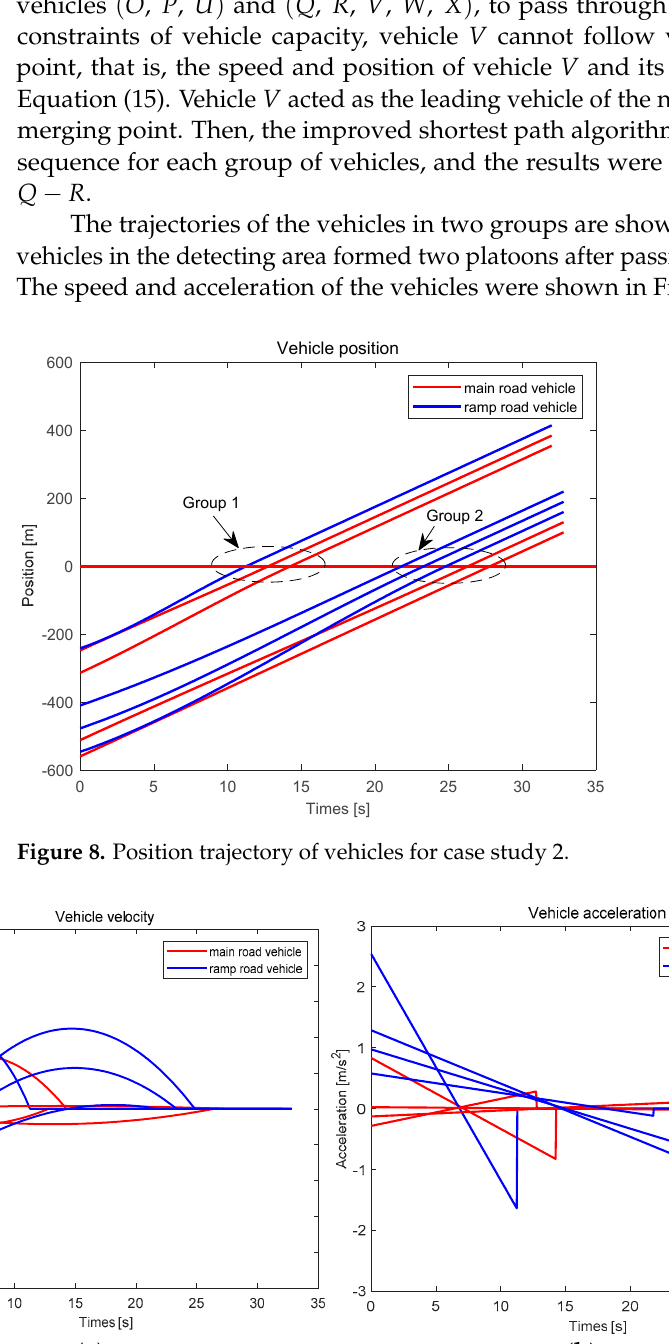
Table 3. The parameters of the vehicles for case study 2.